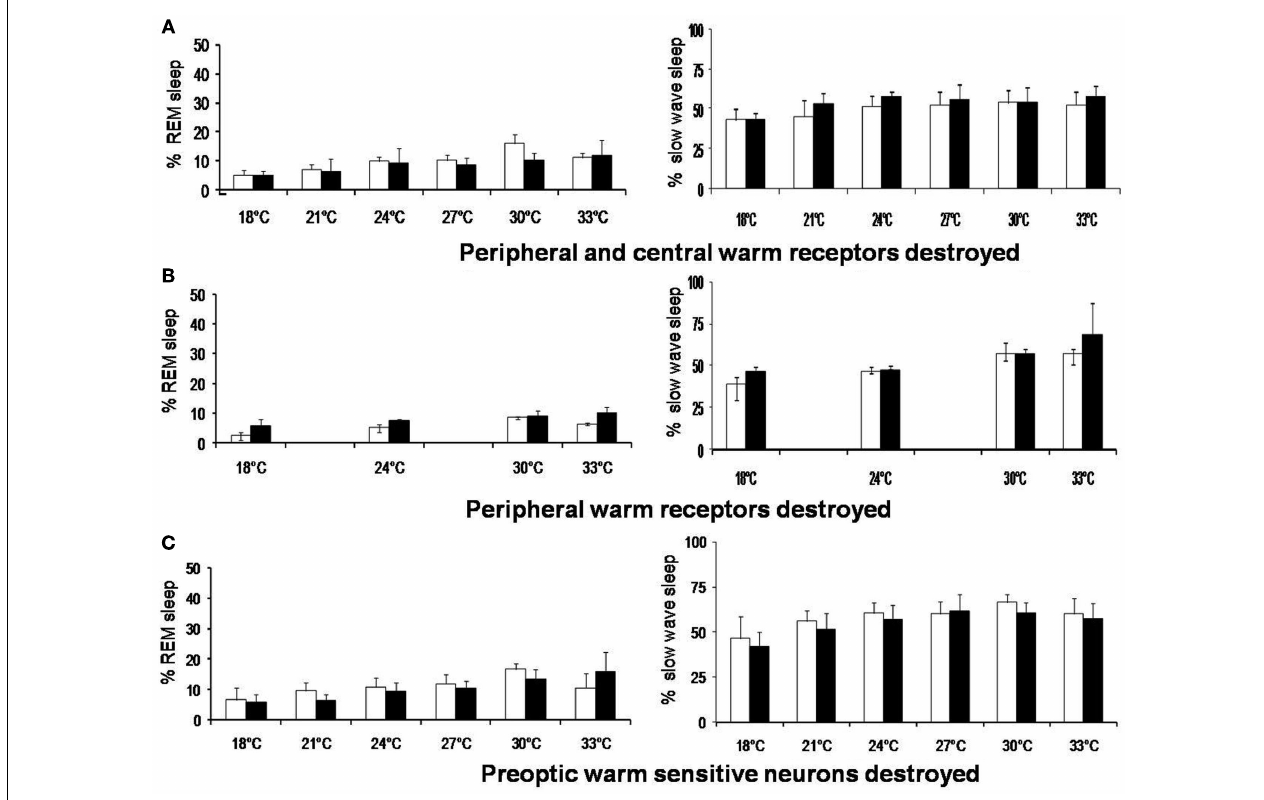
FIGURE 3 | Rapid eye movement sleep and slow wave sleep (% mean ± SD) at different ambient temperature in rats before and after destruction of (A) peripheral and central warm receptors, (B) only peripheral warm receptors, and (C) only preoptic warm sensitive